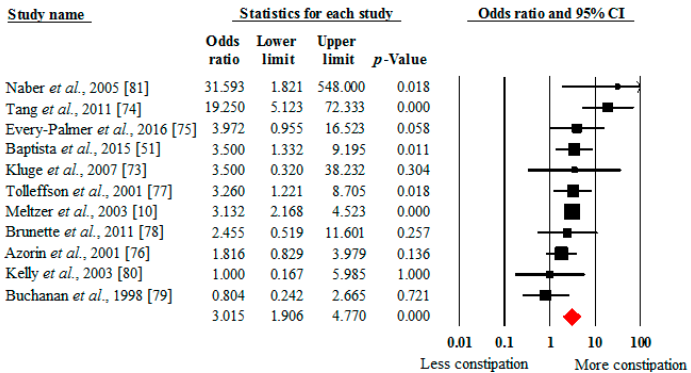
Figure 2. Odds of constipation in people taking clozapine versus other antipsychotics. Black dot = study summary results of mean and standard deviation. Red dot = Pooled summary mean and standard deviation effect size.